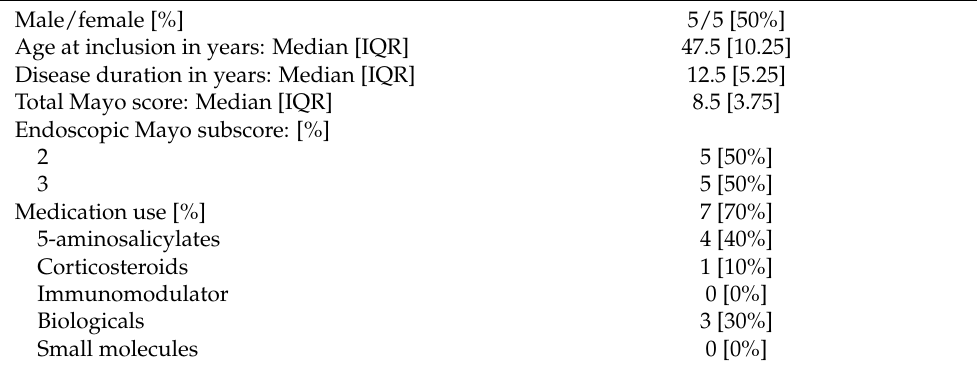
Table 2. Baseline characteristics of patients ( n = 10) at inclusion. IQR = interquartile range. Male/female [%] 5/5 [50%]